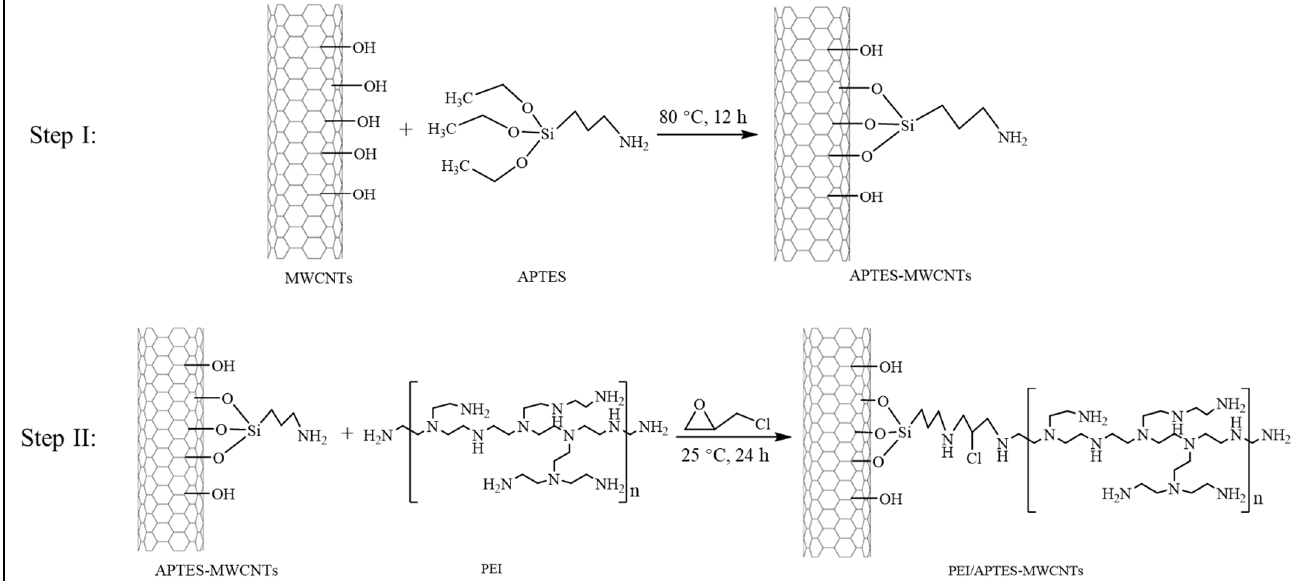
Figure 11. Scheme of the reaction pathway in the preparation of PEI/APTES-MWCNTs.